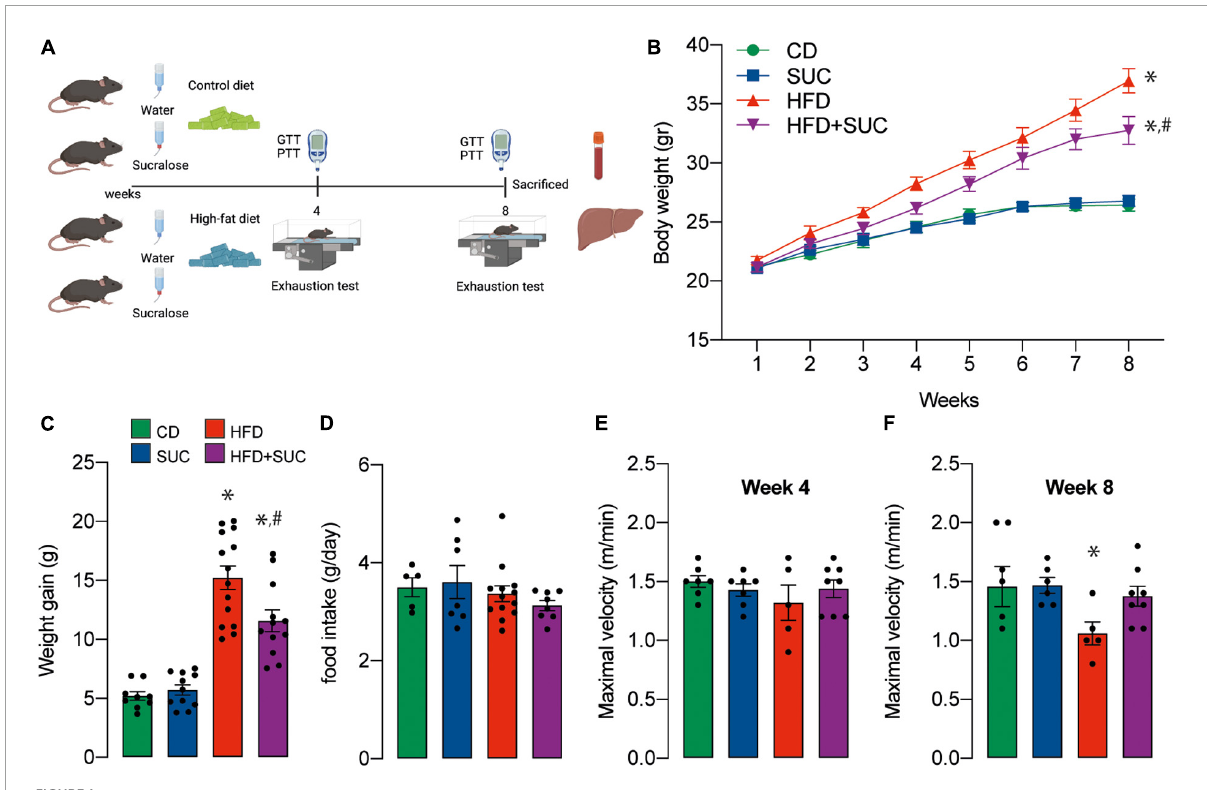
FIGURE1 Sucralose reduces body weight gain and improves physical capacity in mice fed with a high-fat diet. (A) Study design. (B) Body weight. (C) Weight gain. (D) Food intake. (E) Maximal velocity at 4 weeks. (F) Maximal velocity at 8 weeks. Two-way analysis of variance (ANOVA) followed by Holm-Sidak’s post-hoc test. Values are expressed as mean ± SEM. * p < 0.05 vs. CD; # p < 0.05 vs.